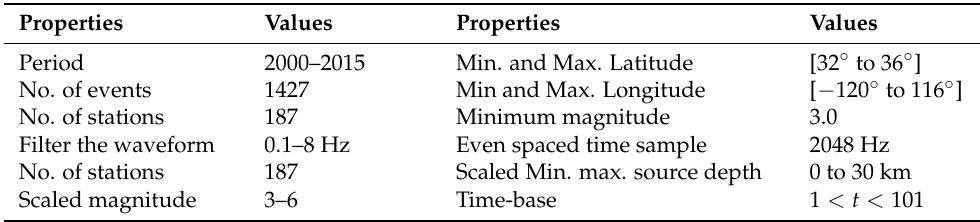
Figure 3. ( a ) Shows the number of stations and their location for the Southern California region. ( b ) Event distribution for California. The depth and magnitude of an event are encoded by its color and size. and size. Table 2. A summary of the Southern California dataset used in this study. Table 2. A summary of the Southern California dataset used in this study.